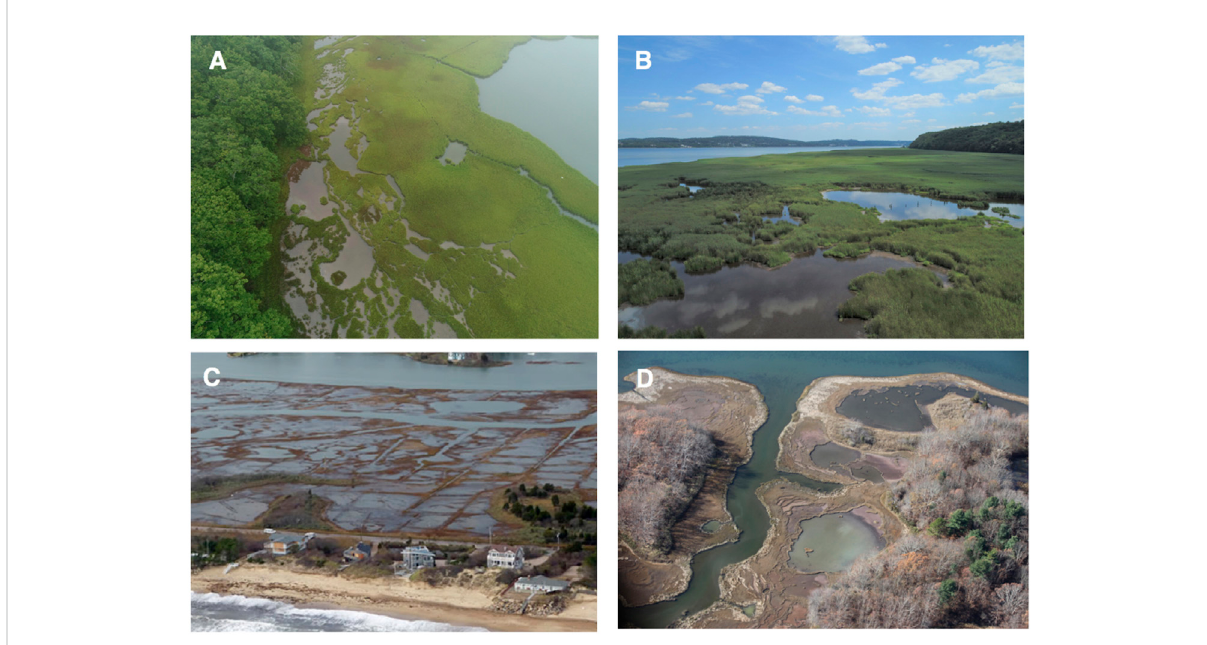
FIGURE 1 Examples oflocations where ponding iscontributing to coastal marshhabitat loss inNew Yorkand New England: (A) BassCreek,ShelterIsland, NY where ponds are expanding at the marsh-upland border; (B) Piermont Marsh, NY where ponds on the marsh interior are expanding; (C) Winnapaug Pond, RI where ponds have formed in grid-ditched marsh islands; and (D) the Pettaquamscutt River Estuary, RI, the focus of this study, where the marsh platform is dominated by large shallow ponds. Photographs courtesy of (A/B) Johannes Krause/Florida International University, (C) Jonathan Stone/Save The Bay, and (D) Greg